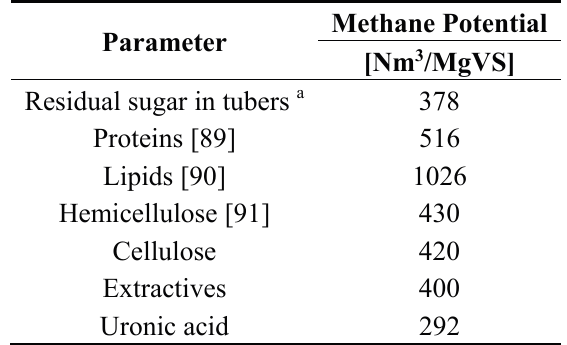
Table 4. Assumed degradation and methane production potentials in anaerobic digestion.